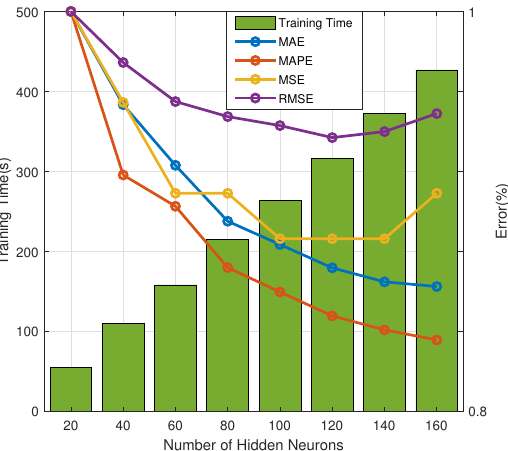
Figure 7. Training time and comparative performance of models with different number of hidden